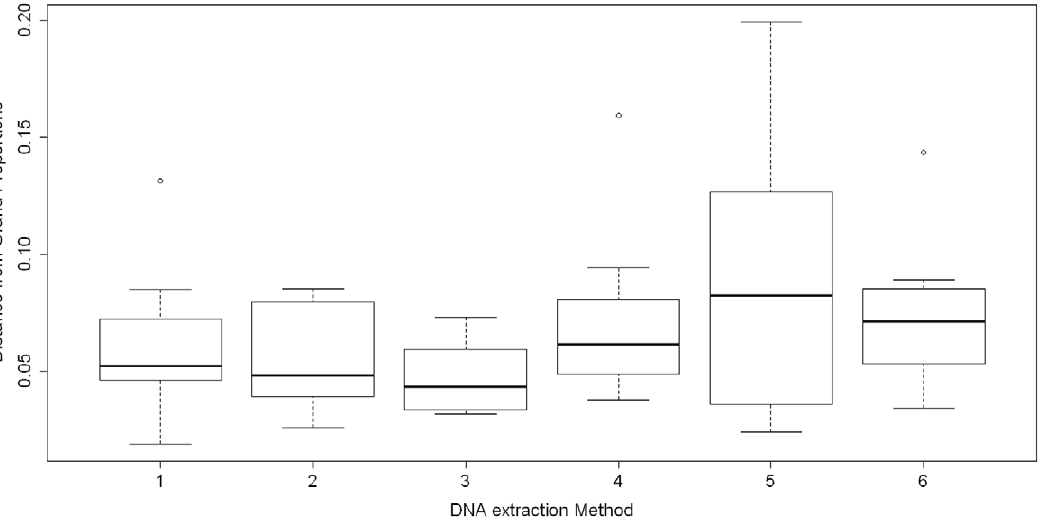
Figure 2. Boxplot of Euclidean distances between observed and grand proportions. To calculate grand proportions, the total counts of 16S rRNA gene reads of each species were calculated for eight replicates of each method. Then grand proportions were calculated based on total counts of 16S rRNA gene reads of each species per method. Grand proportions were used to calculate Euclidean distances between observed and grand proportions.